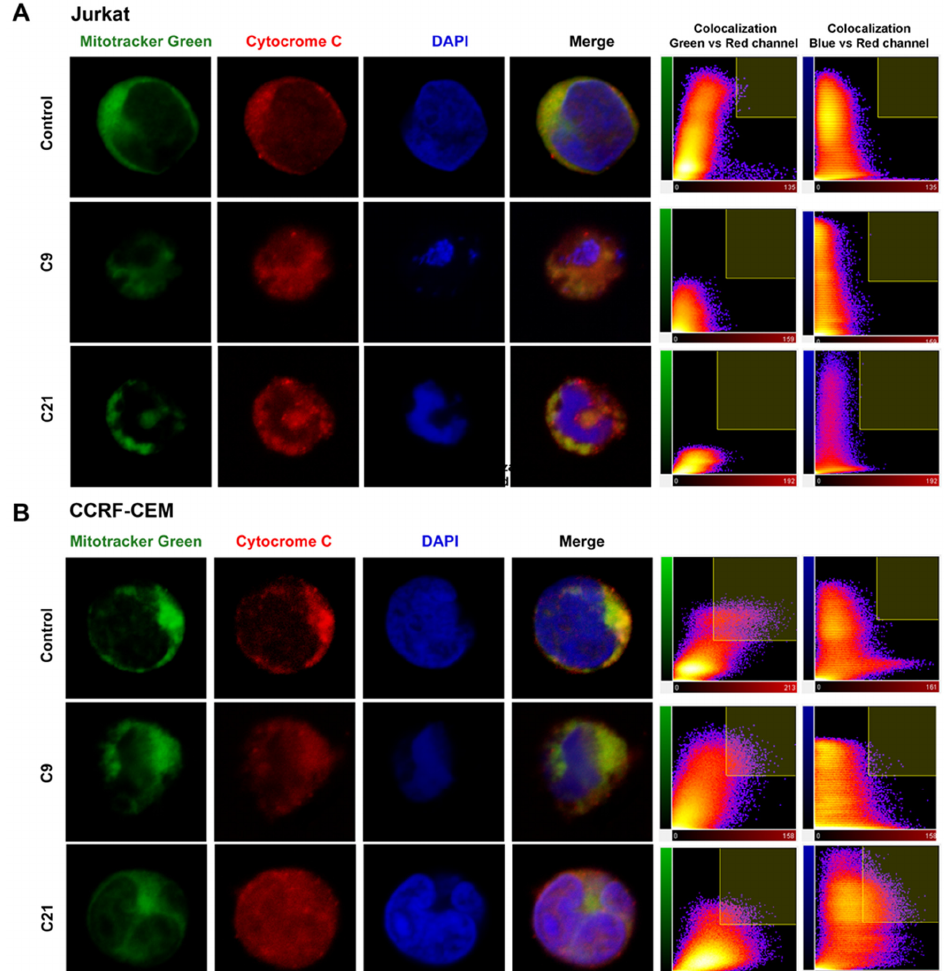
Figure 6. Release of cytochrome C and morphological alterations by compounds. The cells were labeled with MitoTracker Green, anti ‐ cytochrome c antibody/Alexa Fluor 594 and DAPI. Cells were imaged using confocal fluorescence microscopy. Representative single ‐ cell images for each condi ‐ tion (untreated control, C9 and C21 ) are shown. ( A ) Jurkat cells, ( B ) CCRF ‐ CEM cells. Green: Mito ‐ tracker green, fluorescent mitochondrial stain; Red: cytochrome C release stain; Blue: DAPI (4 ′ ,6 ‐ diamidino ‐ 2 ‐ phenylindole), fluorescent DNA stain; Merge: color overlay images of all stains. The colocalization coefficient among the red, green and blue channels is showed on the right. Alterations in nuclear morphology were noticed after treatment with the com ‐ pounds. Compounds C9 and C21 caused DNA fragmentation in Jurkat cells, while in CCRF ‐ CEM cells, the compounds caused shrinkage of the nucleus, with the apparent con ‐ densation of DNA (Figure 6A,B).